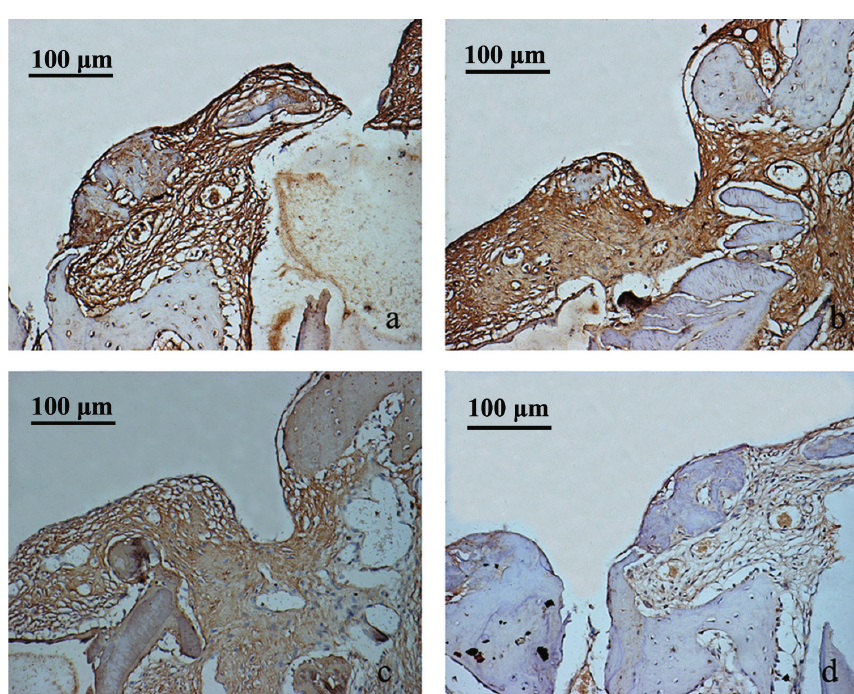
Figure 6- Immunohistochemical staining of Cbfa1 in sections from beagle mandible from test (a and c) and control groups (b and d), during weeks 3 and 8. The expression of Cbfa1 in both groups reached peak values at week 3, but there were no statistically significant differences between test group (a) and control group (b). At week 8, significant differences were observed between both groups, and the expression of Cbfa1 in test group (c) was stronger than in control group (d). Magnification: 200x